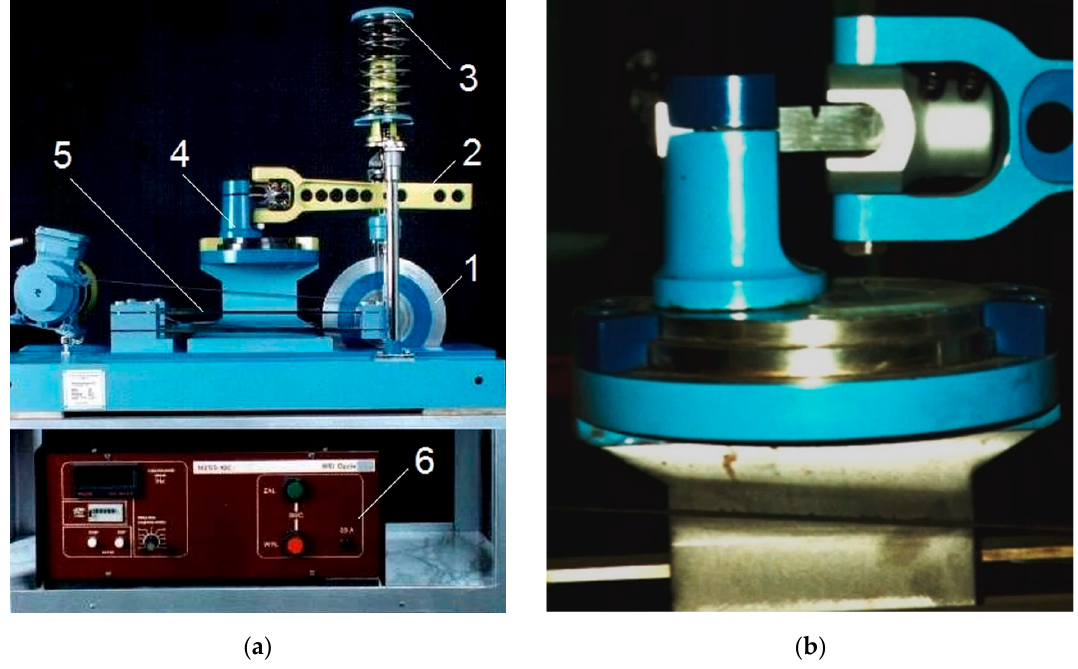
Figure 5. Fatigue test stand MZGS-100: ( a ) Overview; ( b ) specimen during the test.